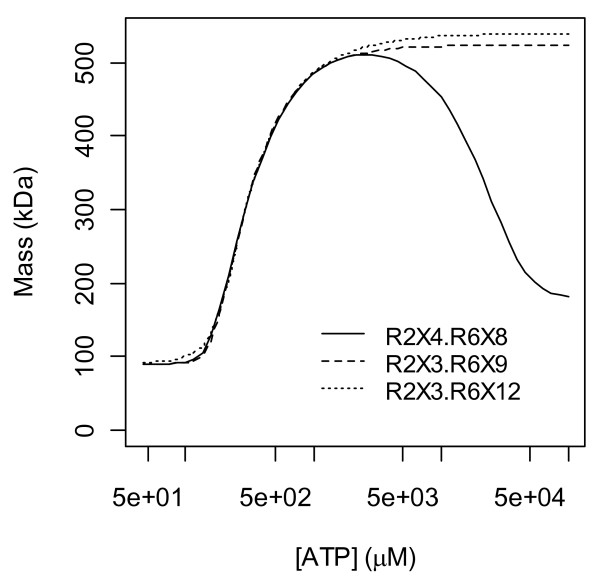
Model limits at large ligand concentrations. In the second model in Fig. 8 and Table 1 (solid line here) the dimer term R2X4 causes a below expectation peak (510 instead of 540) at high [ATP]. In the limit of very high [ATP], this model is dominated by the R2X4 term (average mass approaches 180 kDa) because this term partitions more X into a bound state with R than the hexamer R6X8, i.e. 4/2 = 2 > 8/6 = 1.3. These ratios are both 1.5 in the model R2X3.R6X9 (dashed line) which has a balanced population in this limit (with a limiting average mass of 523 kDa). These ratios are 1.5 and 2 in the model R2X3.R6X12 (dotted) which yields pure hexamers (average mass = 540 kDa) in the limit of infinite ATP.